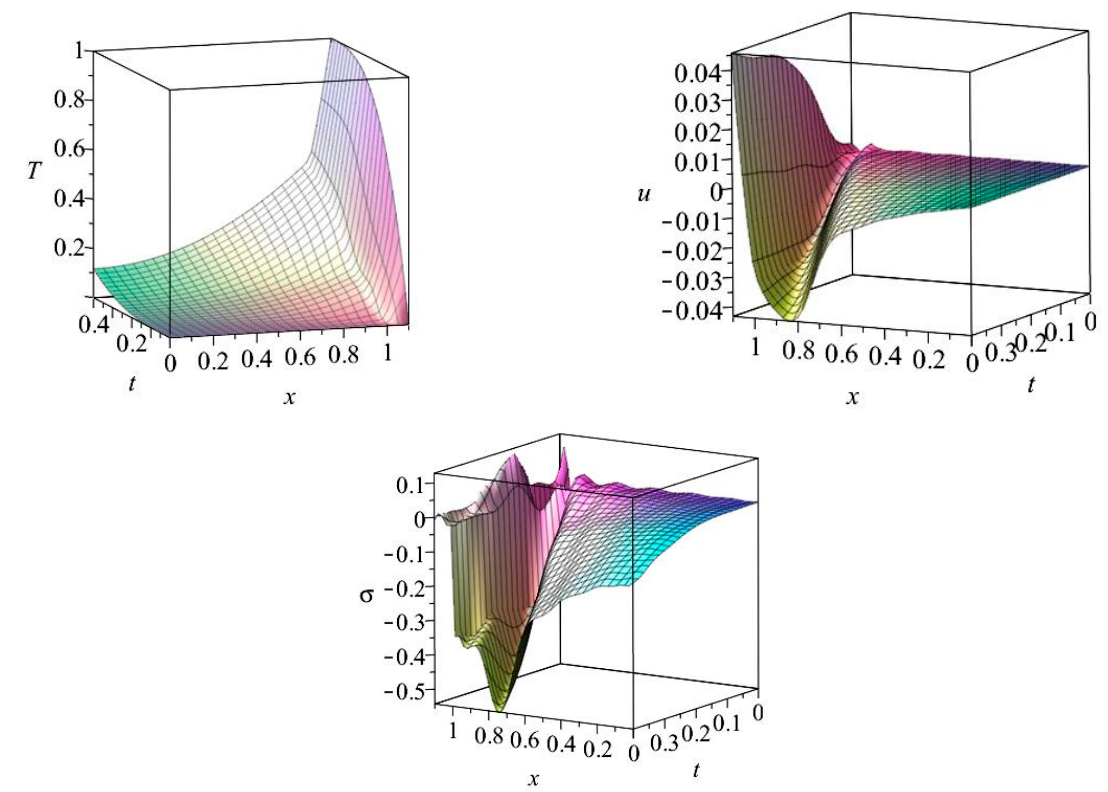
Figure 5. The thermal conductivity coefficient increased by four times for layer 2, the thickness of the layers remained unchanged.